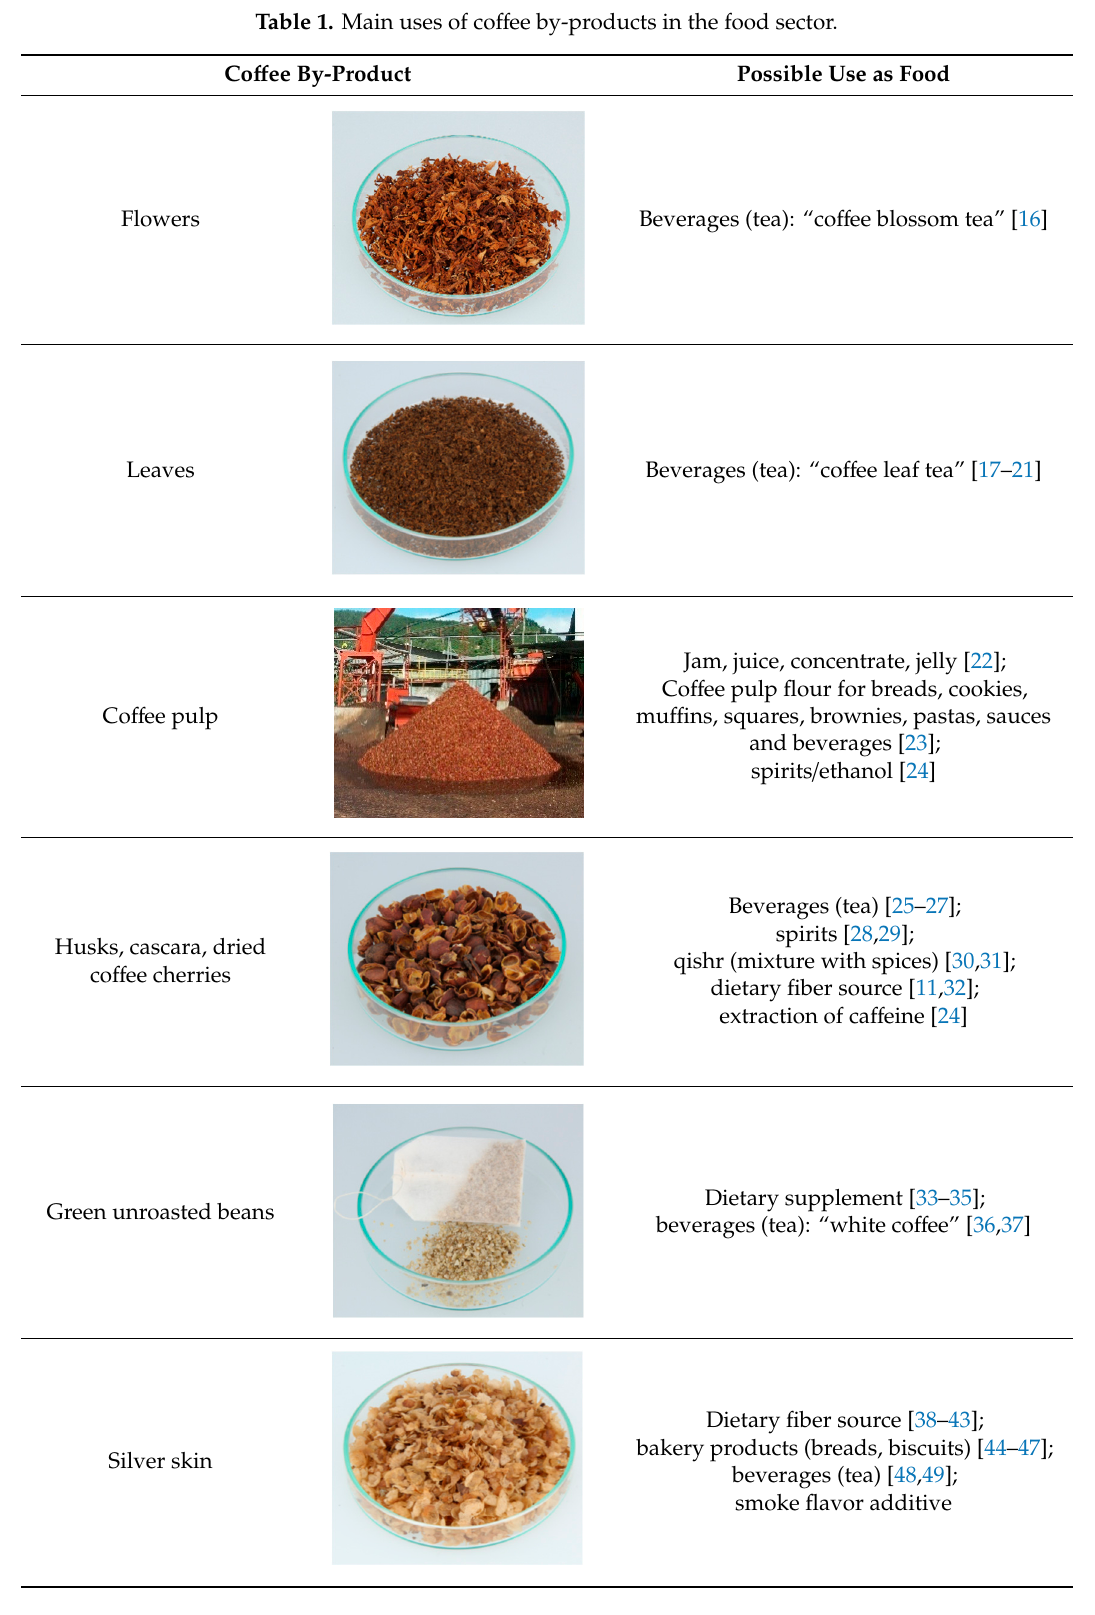
Table 1. Main uses of coffee by-products in the food